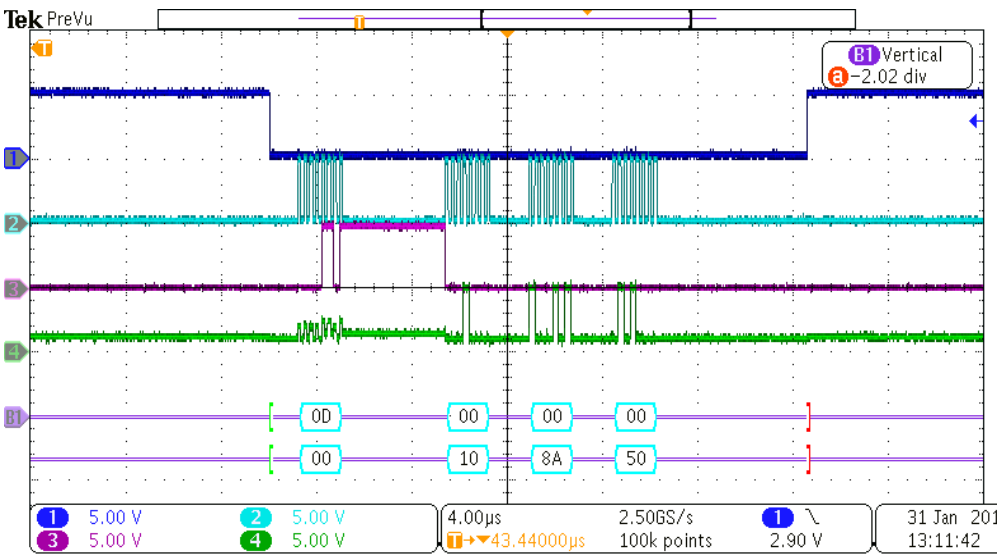
Figure 7. Communication between ADE7758 IC and ATMega328P when the V RMS register is read (Ch1. SS, Ch2. SCLK, Ch3. MOSI, Ch4. MISO).